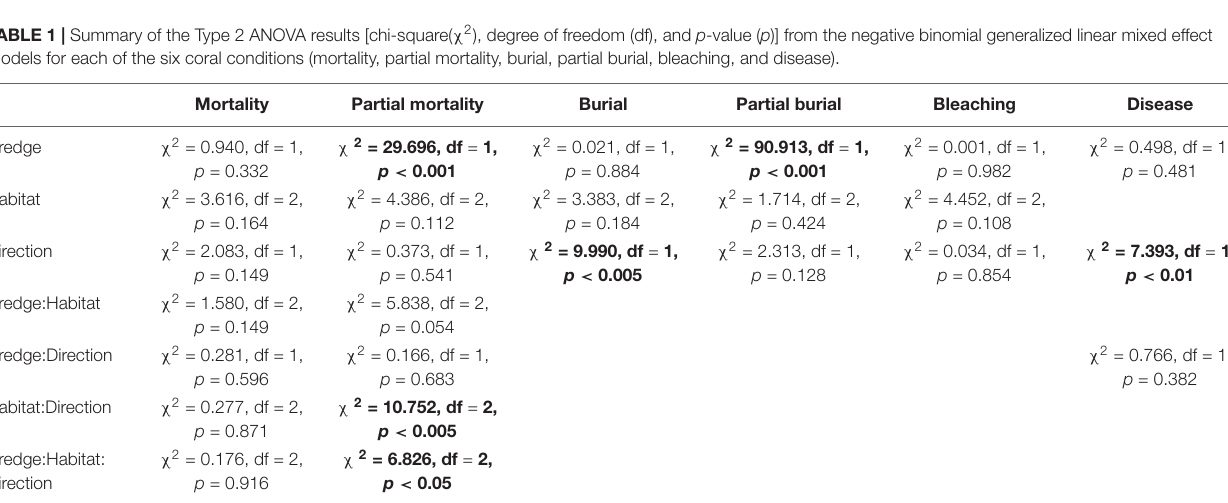
FIGURE 2 | Coral conditions (buried, bleaching, disease, and mortality) plotted by month over the 21-month monitoring period. The timing of dredging, the 2014 summer hyperthermal event and the onset of the Stony Coral Tissue Loss Disease (SCLTD) outbreak starting in September 2014 are also shown. Number of corals with each of the conditions is labeled for each month. Cumulative mortality is plotted in red.